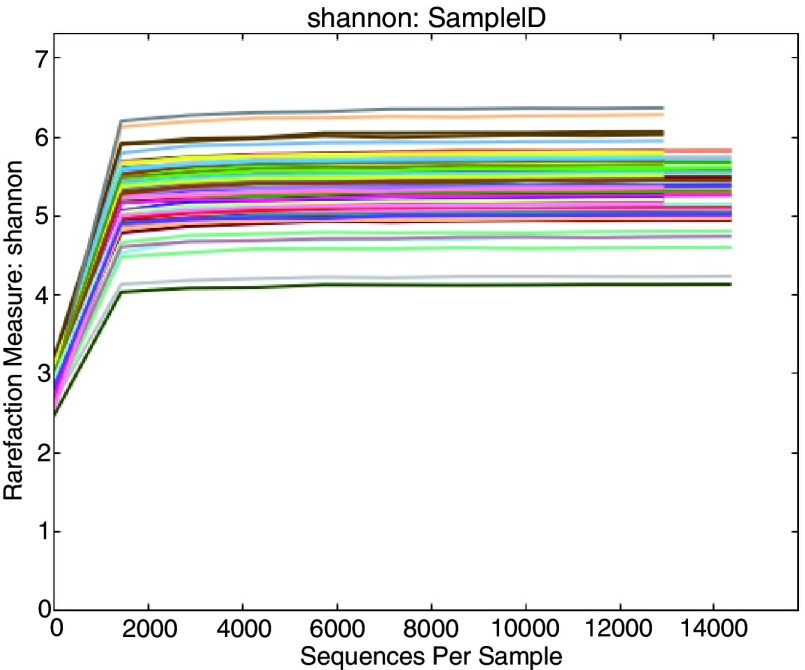
Rarefaction curve plotted using alpha diversity metric, Shannon index against number of sequences per sample. Each coloured line represents one biological sample.